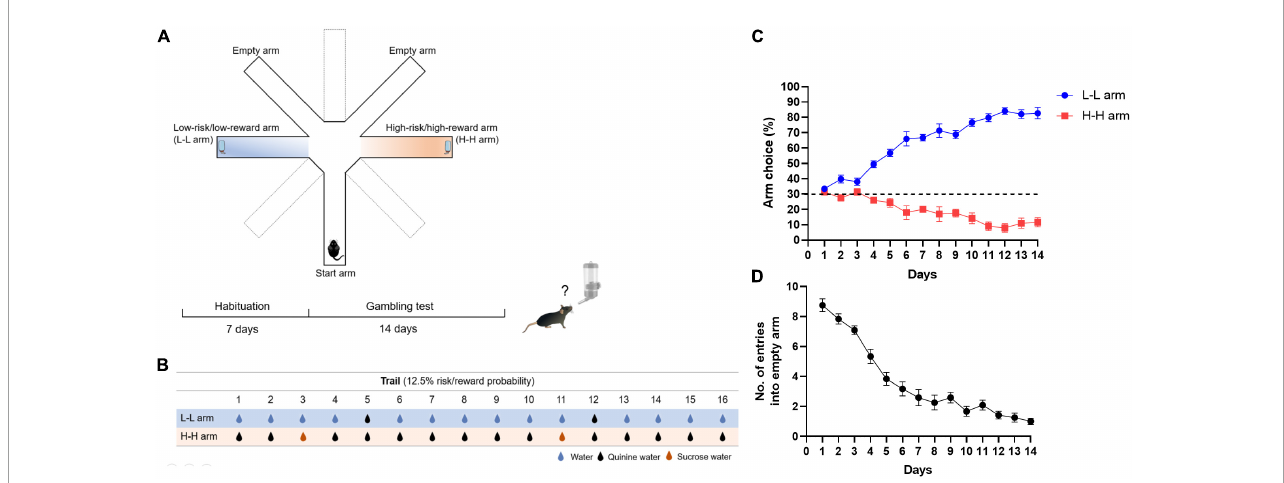
FIGURE1 Risk decision-making test for mice. (A) Schematic diagram of experimental apparatus and procedure. The apparatus consisted of a start arm and four choice arms, including one low-risk/low-reward baited arm (L-L arm), one high-risk/high-reward baited arm (H-H arm), and two empty arms. A water bottle was glued at the end of the baited arm. (B) Risk/reward probabilities of the L-L arm and H-H arm. Under the standard condition, the choice of the L-L arm resulted in small risk (2/16 trials, risk probability: 12.5%) with frequent normal water (14/16 trials, 87.5%). Choice of the H-H arm resulted in infrequent reward (2/16 trials, reward probability: 12.5%) with more significant risk (14/16 trials, 87.5%). Blue droplets: normal water; black droplets: quinine water; red droplets: sucrose water. (C) Performance of mice in the gambling test. A dotted line indicates the level of chance for arm choice. (D) The number of entries into empty